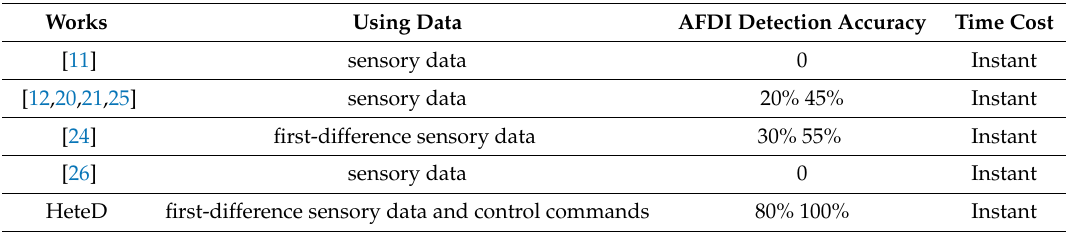
Table 5. Characters of Previous FDI